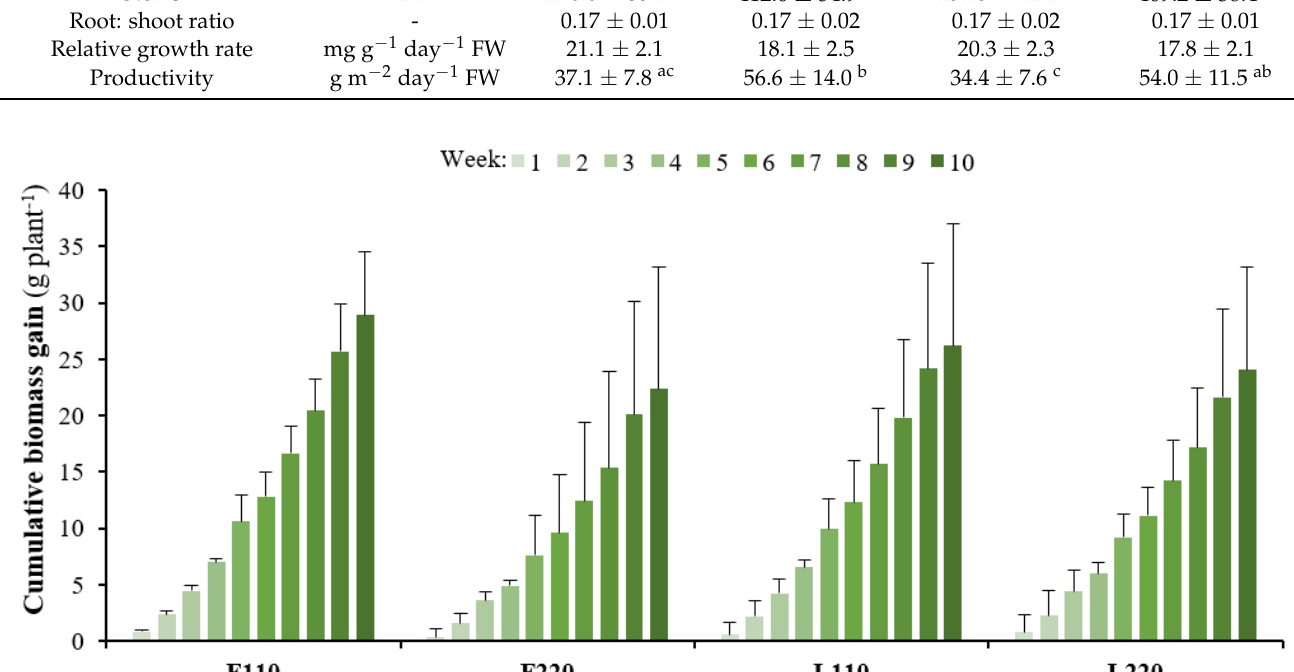
Figure 2. Individual cumulative weight gain ( n = 5). Error bars represent standard deviations.